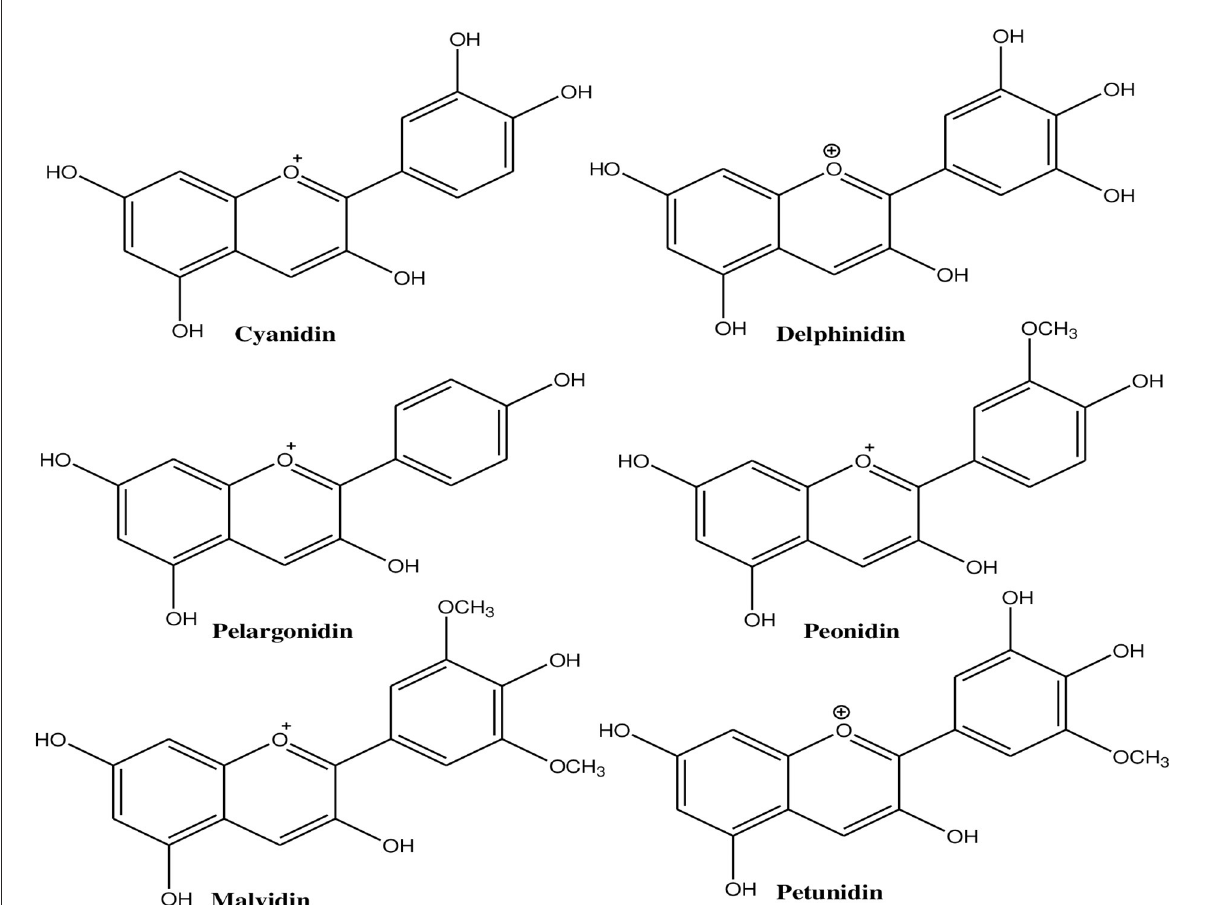
FIGURE3 Different types of anthocyanins present in onion that contain -OH or -OCH 3 groups at different positions.